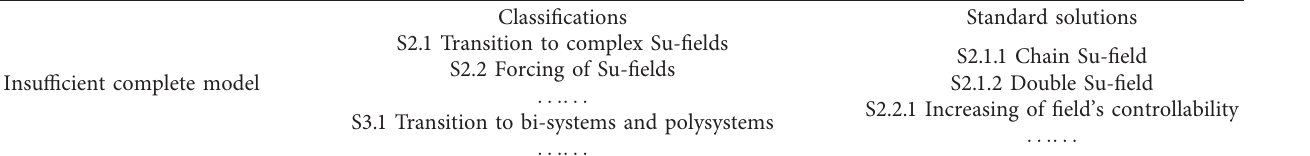
Figure 5: The substance-field model of the torque problem. Table 2: Standard solutions for insufficient complete